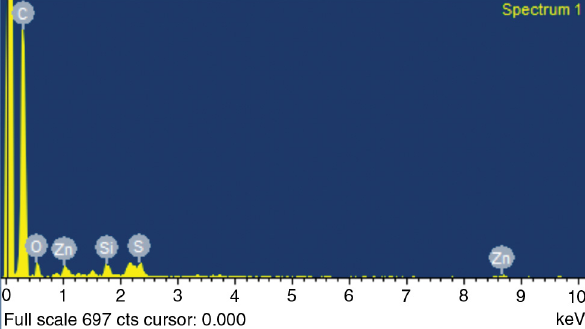
Figure 3: FE-SEM image of Crumb Rubber indicating its composition.